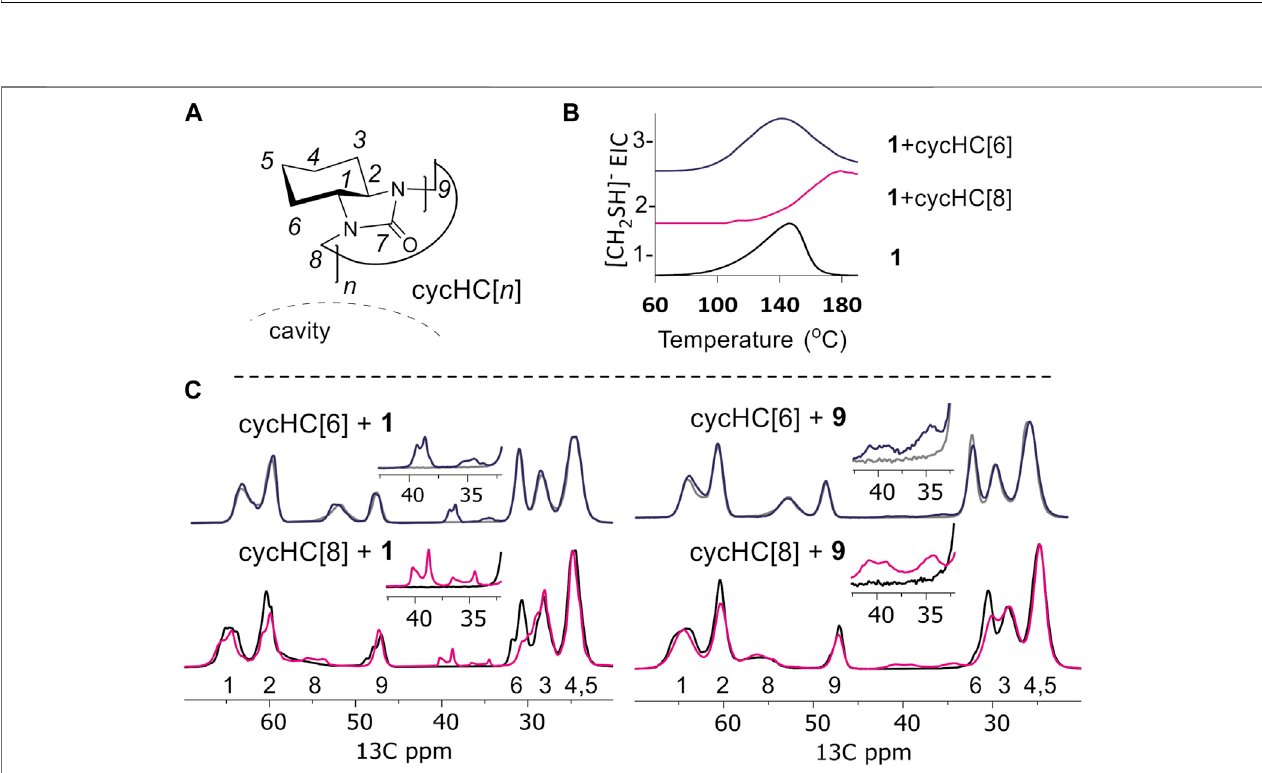
FIGURE 5 | (A) Structure of cycHC[ n ] with atom numeration and cavity direction; (B) extracted ion current (EIC) of one fragment in TGA: 1 - pure 1 , 2 - cycHC[8] after extraction of 1 , 3 - cycHC[6] after extraction of 1 ; (C) 13 C ssNMR stacked spectra of cycHC[ n ] before and after milling with guests: upper left - 1 + cycHC[6] (blue) overlaid withcycHC[6] (gray); lower left – 1 + cycHC[8] (pink) overlaid with cycHC[8] (black); upper right - 9 +cycHC[6] (blue) overlaid with cycHC[6] (gray);lowerright – 9 + cycHC[8] (pink) overlaid with cycHC[8] (black).